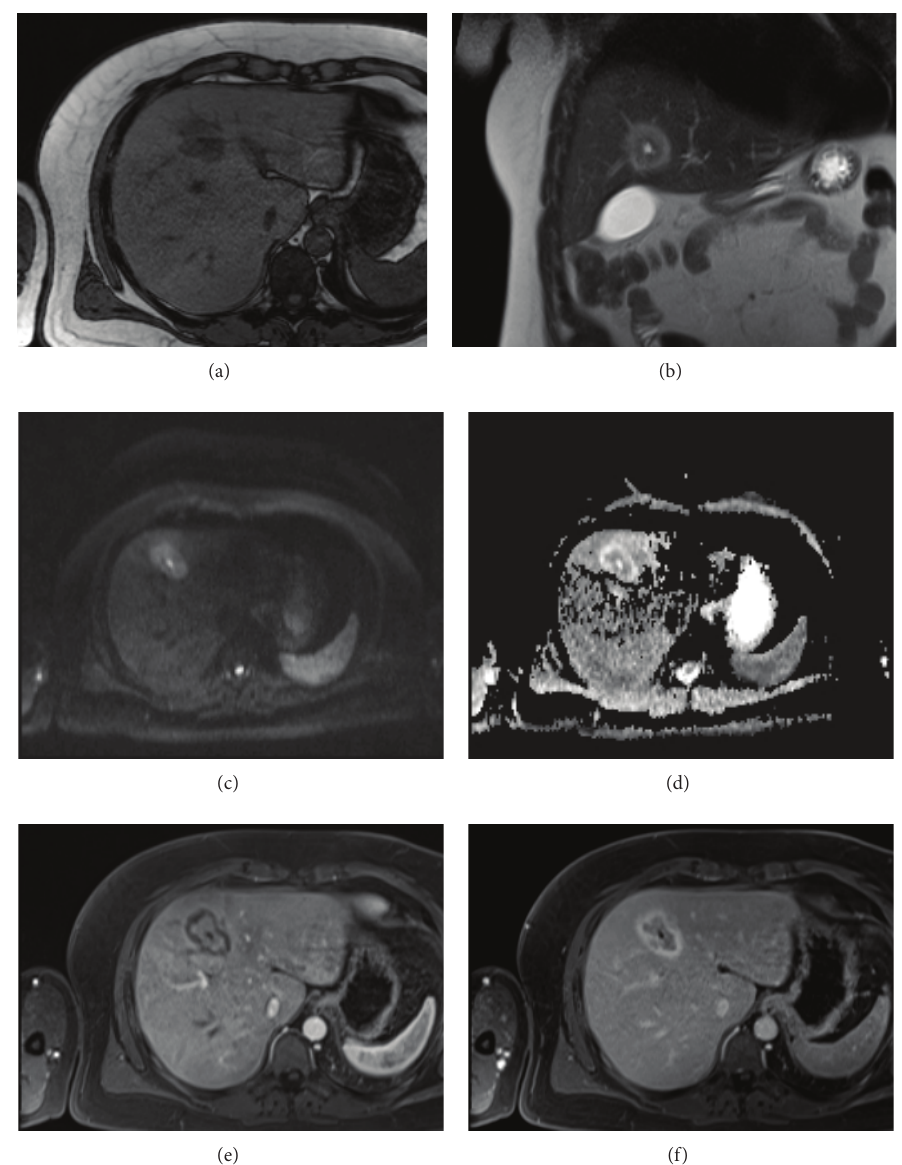
Figure2:MRIoftheliver.(a)ThenodularmassishypointenseonaxialGET1-weightedout-of-phaseMRI.(b)Thelesionexhibitsatarget-like appearance on coronal T2-weighted HASTE MRI, the rim being higher in signal intensity than the central component. The tine colliquative , while the rim is not appreciable; the colliquative nucleus and core is clearly visible. (c) The central component is hyperintense on DWI b 400 the cerebrospinal fluid are hyperintense because of T2-shine-through effect. (d) ADC map shows no water diffusion restriction of the rim and the core. (e) and (f) Contrast-enhanced pattern of the nodule on dynamic MRI (arterial and late venous phases) is similar to the pattern of dynamic